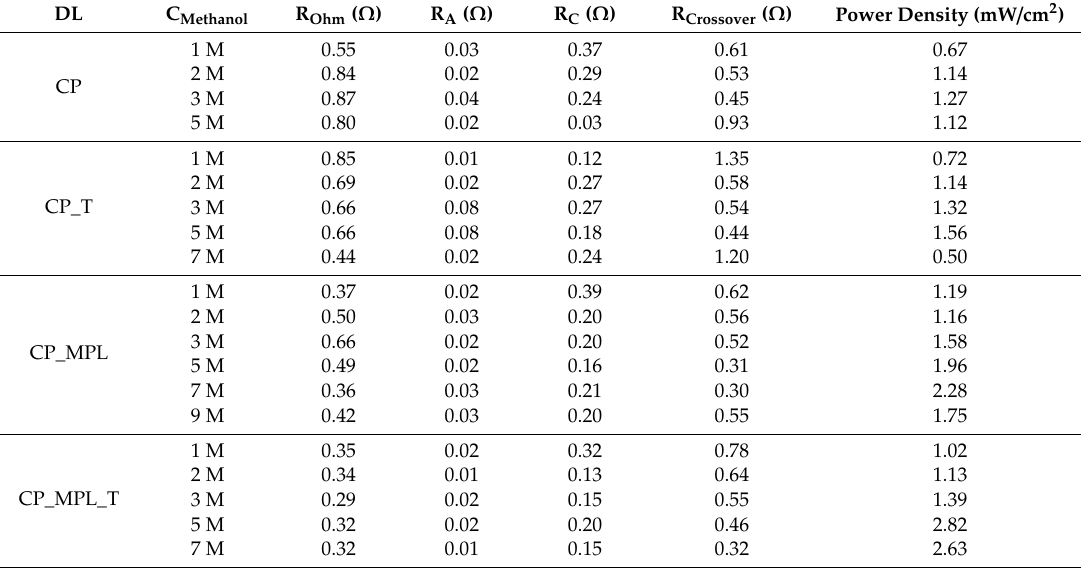
Table 3. EIS data estimated from the EEC proposed in Figure 3 for di ff erent carbon papers as ADL and the maximum power density achieved for each